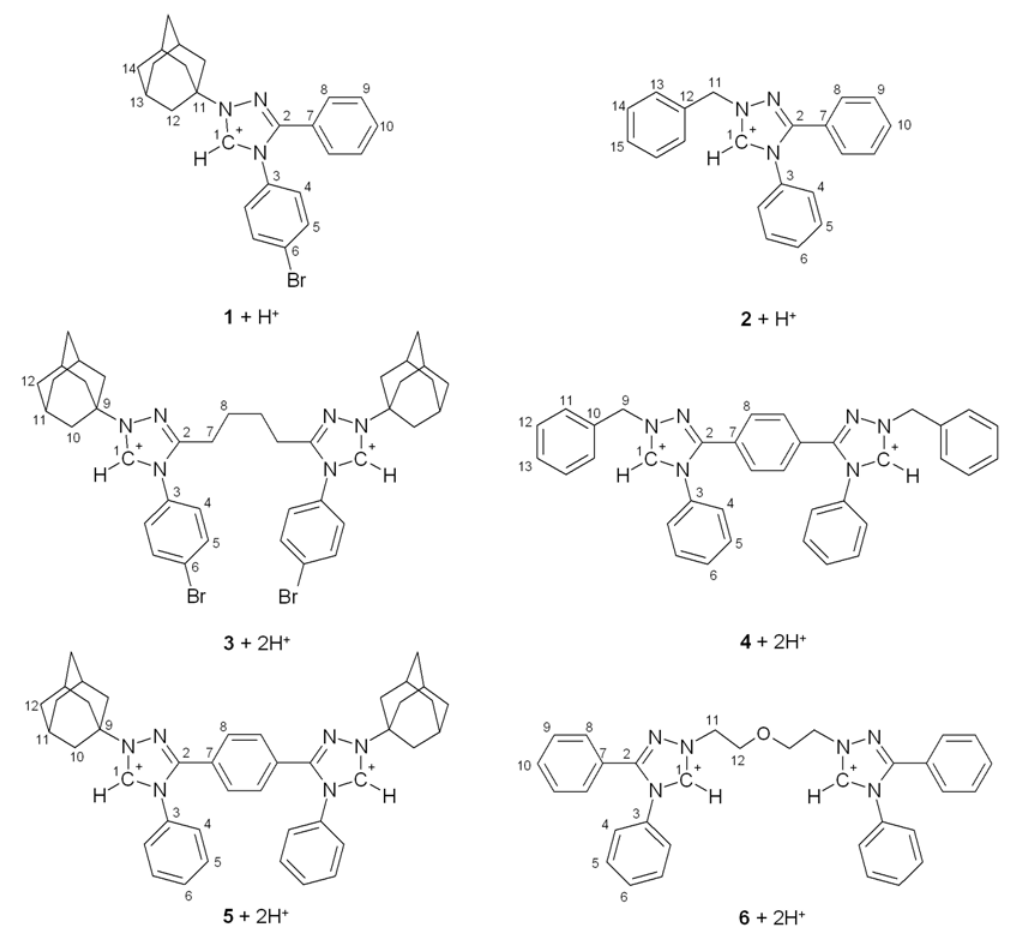
Scheme 2 Carbene precursors